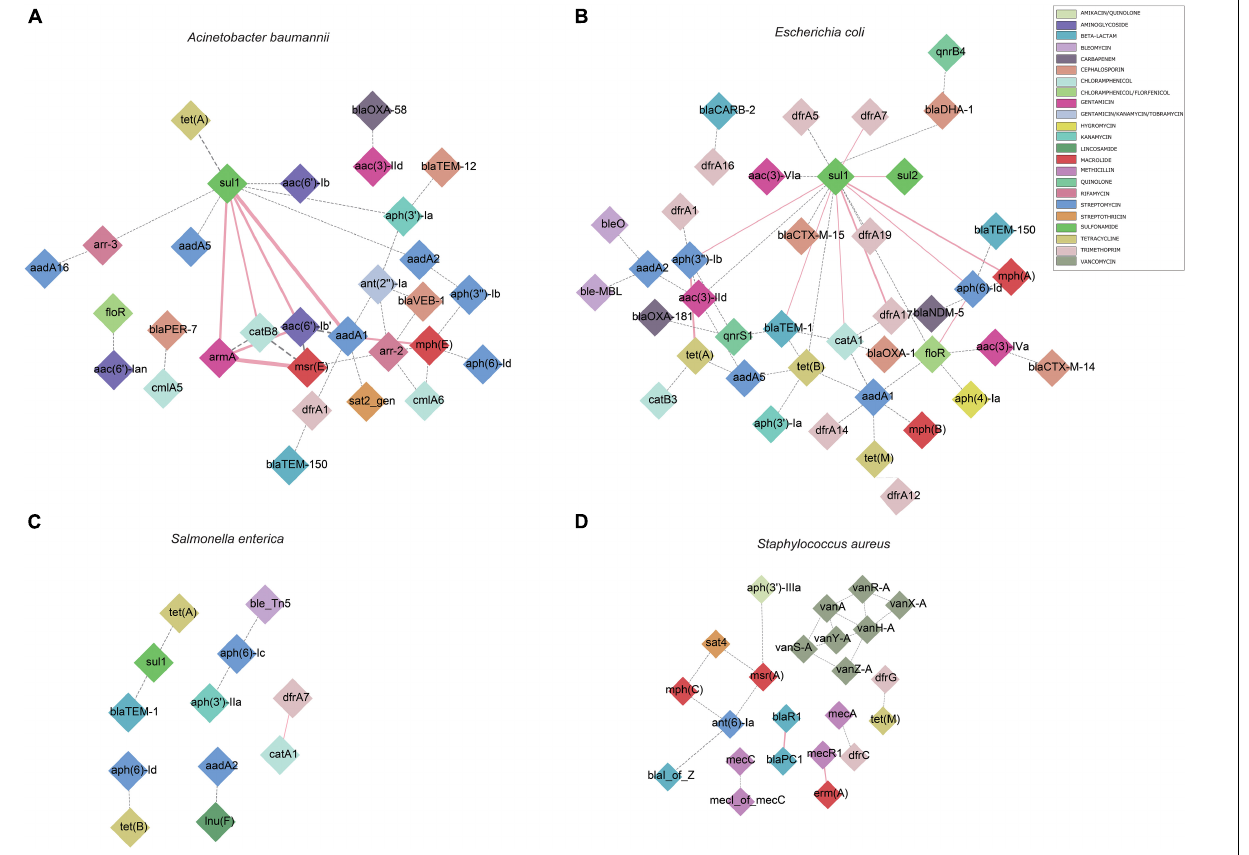
FIGURE 3 | Genomic proximity of antibiotic resistance genes (ARGs) in four species: (A) A. baumannii , (B) E. coli , (C) S. enterica , (D) S. aureus . ARG pairs with a distance of less than 10 kb and frequency of occurrence no less than 10 were screened to construct the network. Diamonds are used to represent ARGs, solid lines are used to represent gene pairs whose frequency is not less than 80% of the total number and labeled as pink, dotted lines represent gene pairs with frequency less than 80% of the total number and are marked as gray, and the width of the line indicates the frequency. Different antibiotics are displayed in different colors, corresponding to the